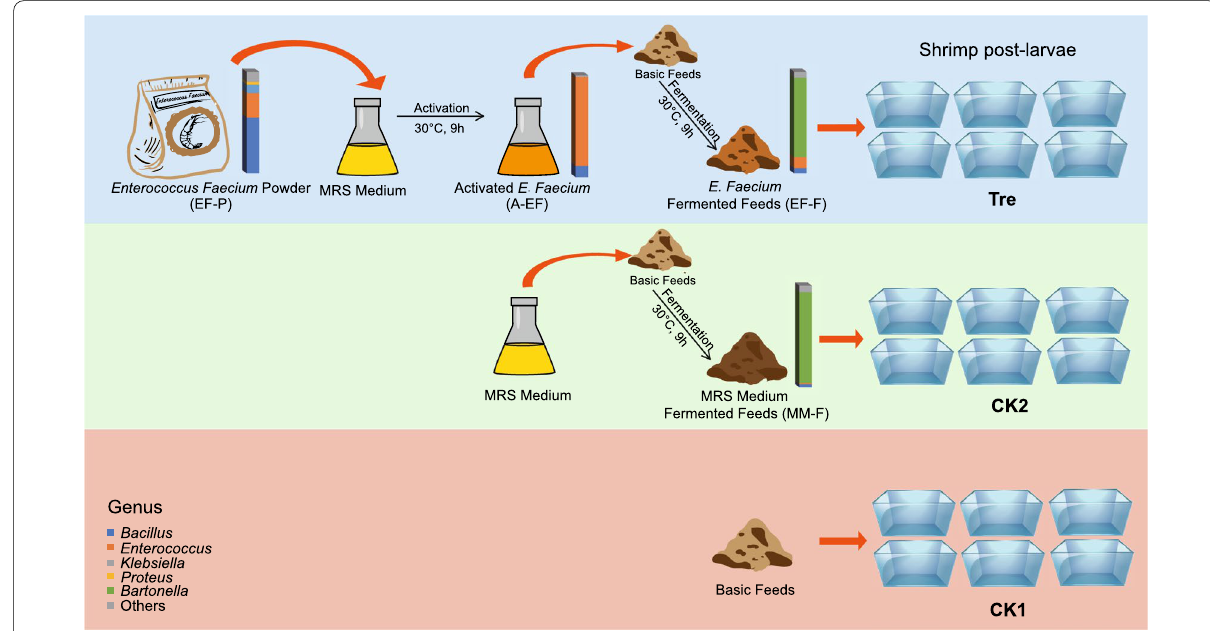
Fig. 1 Experimental design and the dynamic compositional variation of Enterococcus faecium powder (EF-P) (bar chart, abundant (average relative abundance > 1%) genera in